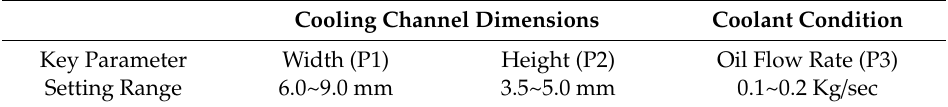
Table 4. Cooling channel dimension and relevant parameter setting ranges.